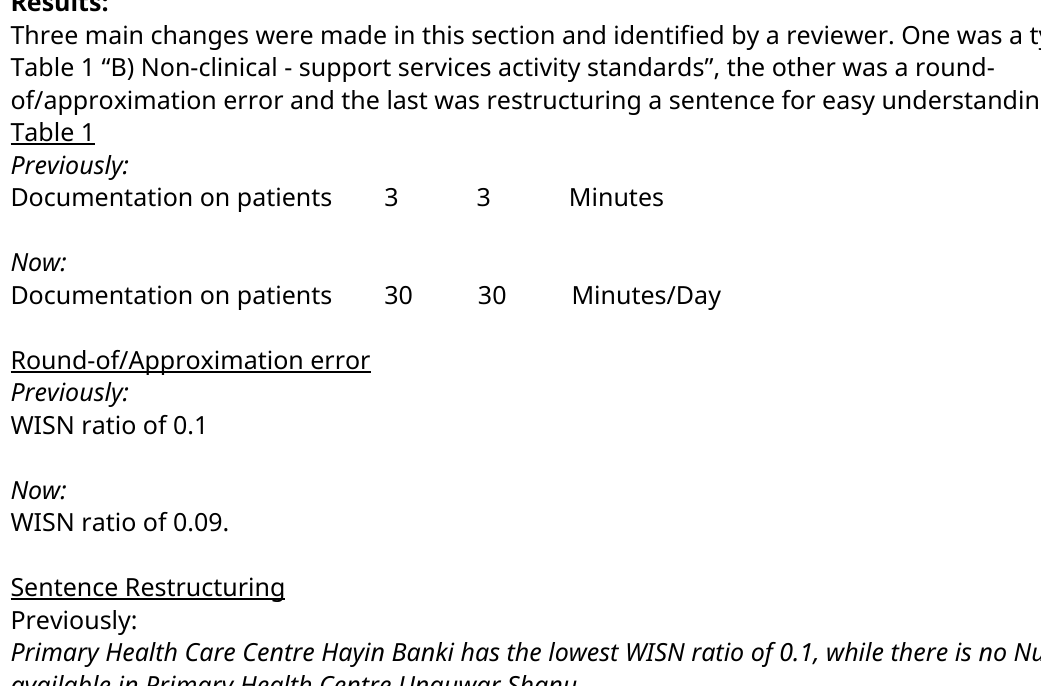
Documentation on